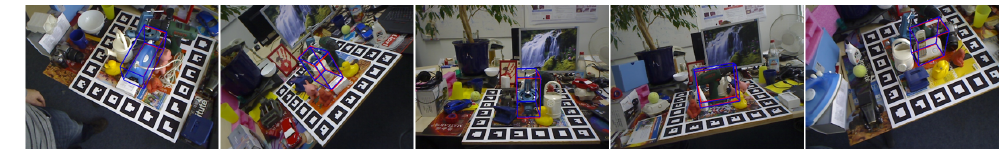
Figure 1. We visualize examples of the estimated pose using only SynPo-Net (without pose refine- ment). The groundtruth 3D bounding box and the predicted 3D bounding box are represented in red and blue,